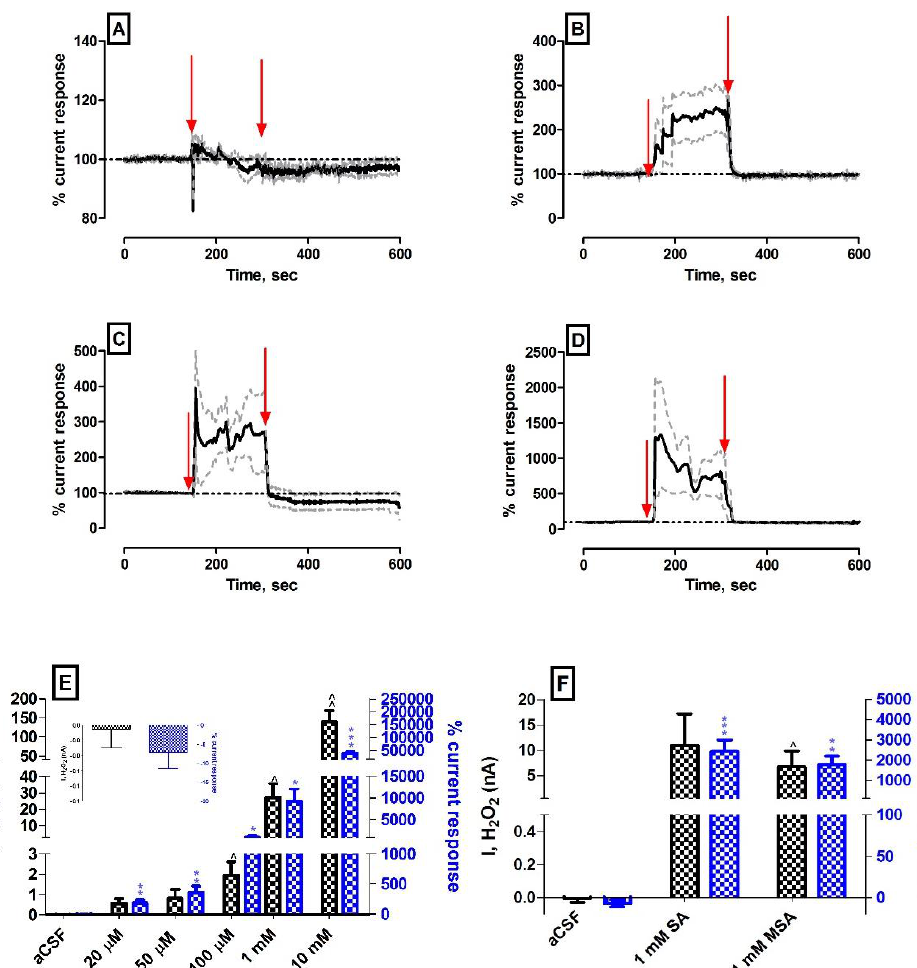
Figure 4 . Averaged raw data percentage response of subtracted current from H 2 O 2 biosensor co-implanted with a microinfusion probe in the striatum of anaesthetised NOD SCID mice ( n = 5) to: ( A ) infusion of aCSF; ( B ) infusion of 20 µ M H 2 O 2 /aCSF; ( C ) infusion of 50 µ M H 2 O 2 /aCSF; and ( D ) infusion of 100 µ M H 2 O 2 /aCSF. Red arrows indicate start/end of 150-s infusion. Mean percentage current response represented by black trace, percentage error represented by grey